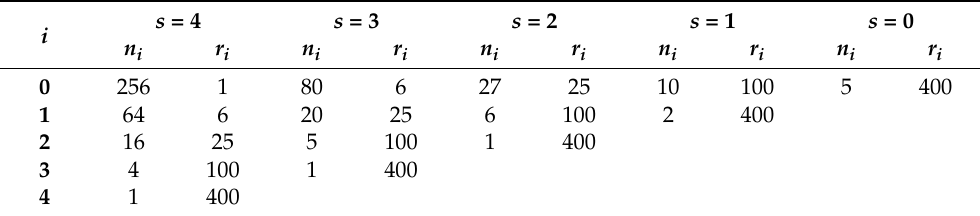
Table 1. Hyperband algorithm with R = 400 and η =